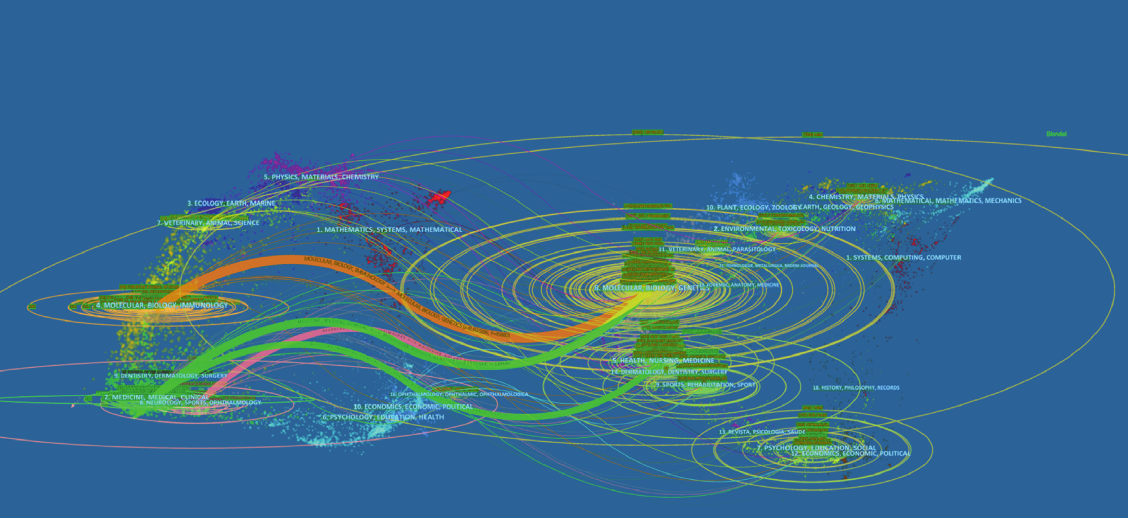
Figure 3: The dual-map overlay of journals related to pain and inflammation